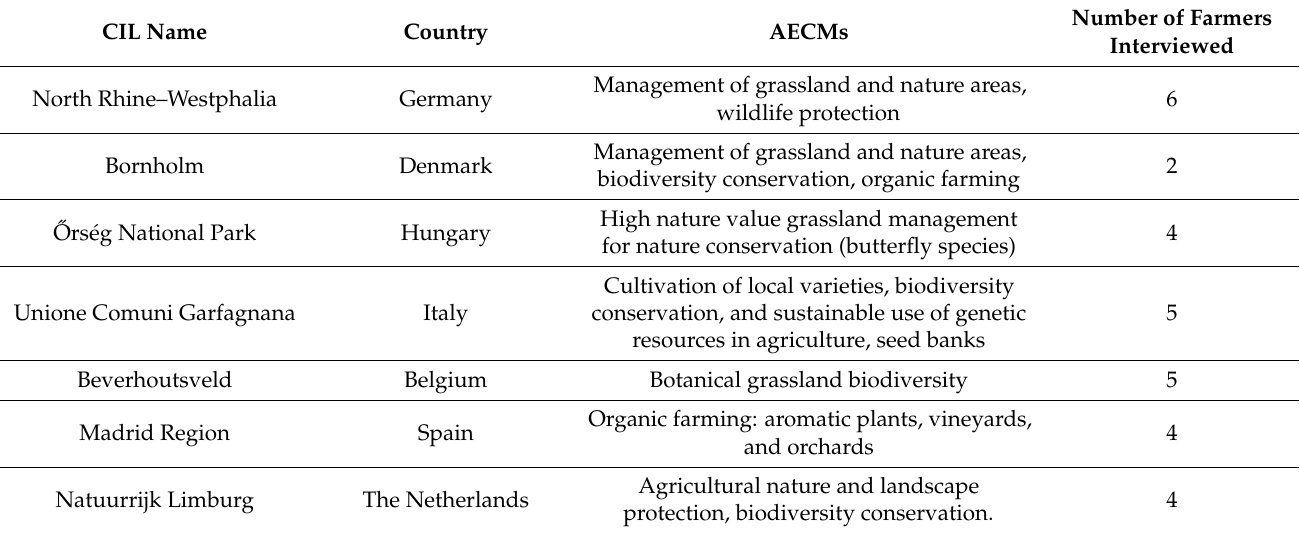
Table 1. CILs included in the analysis and focus of the AECMs that farmers were involved